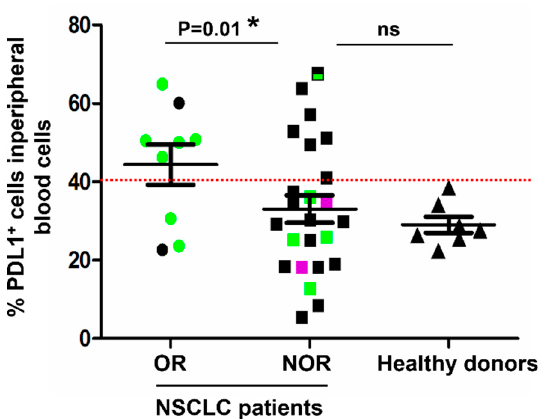
Figure 3. Quantification of PD-L1 + cell subsets in systemic immune cells and correlation with clinical responses. Dot plot graph representing the percentage of PD-L1 + cells within total systemic immune cells quantified from fresh peripheral blood samples before the start of immunotherapies, in objective responders (OR, N = 9), non-responders (NOR, N = 24), and healthy donors (N = 7). Relevant statistical comparisons are shown within the graph, by the exact test of Fisher. In green, patients with >40% circulating memory CD4 T cells. In purple, patients with stable disease. In black, patients with <40% circulating memory CD4 T cells. The dotted red line indicates the cut-off value used to test the association of the percentage of PD-L1 + T cells with clinical responses.